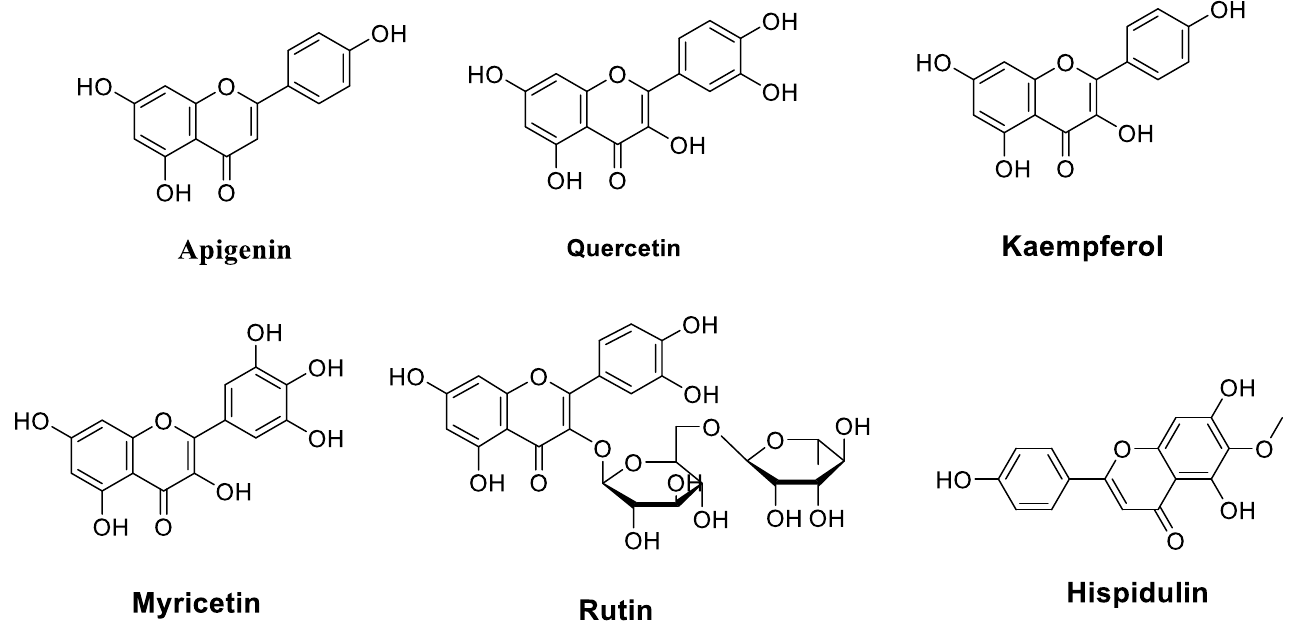
Figure 2. Chemical structures of flavonoids that improve the chemosensitivity of anticancer